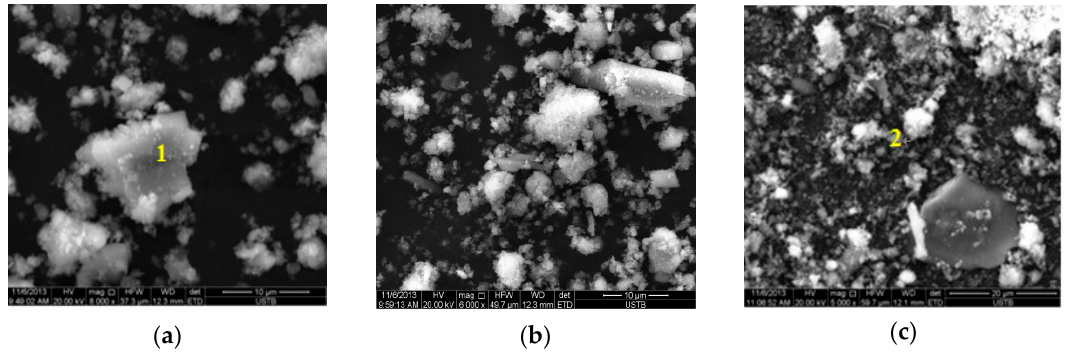
Figure 5. SEM micrographs of filling slurry without special additive at different hydration ages: ( a ) 30 min; ( b ) 2 h; ( c ) 1 day.